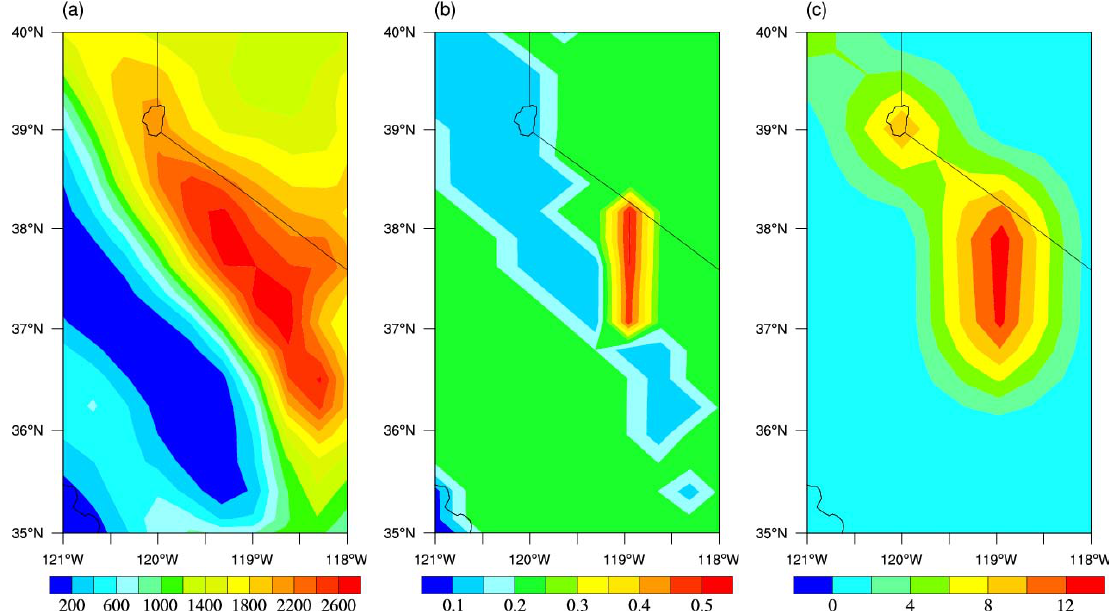
Fig. 2. Maps of the (a) elevation, (b) surface albedo, and (b) snow water equivalent (kgm − 2 ) used in WRF simulations (30 × 30km 2 resolution) in the Sierra-Nevada